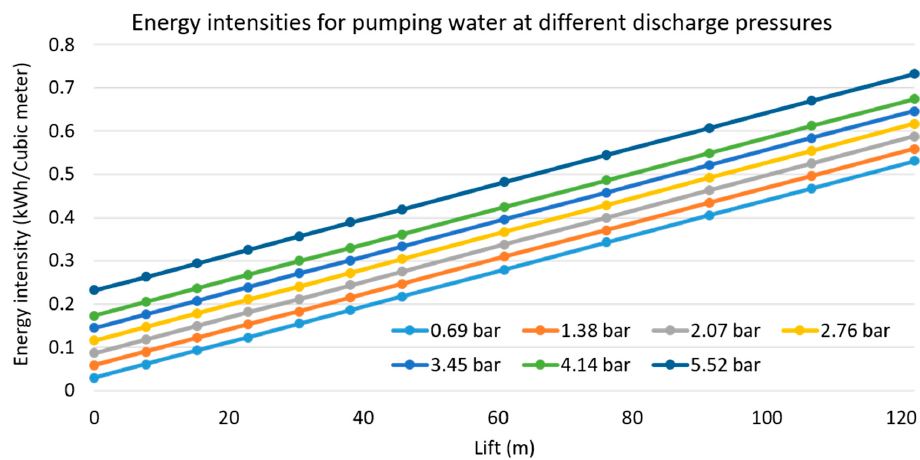
Figure 6. Energy intensity for pumping water (kWh / cubic meter).